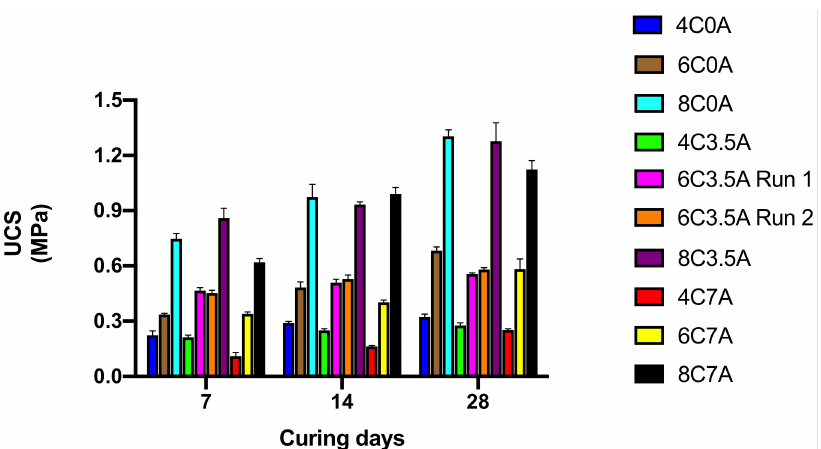
Figure 10. Unconfined compressive strength of backfill mixtures after 7, 14, and 28 days of curing (see Table 5 for mixture